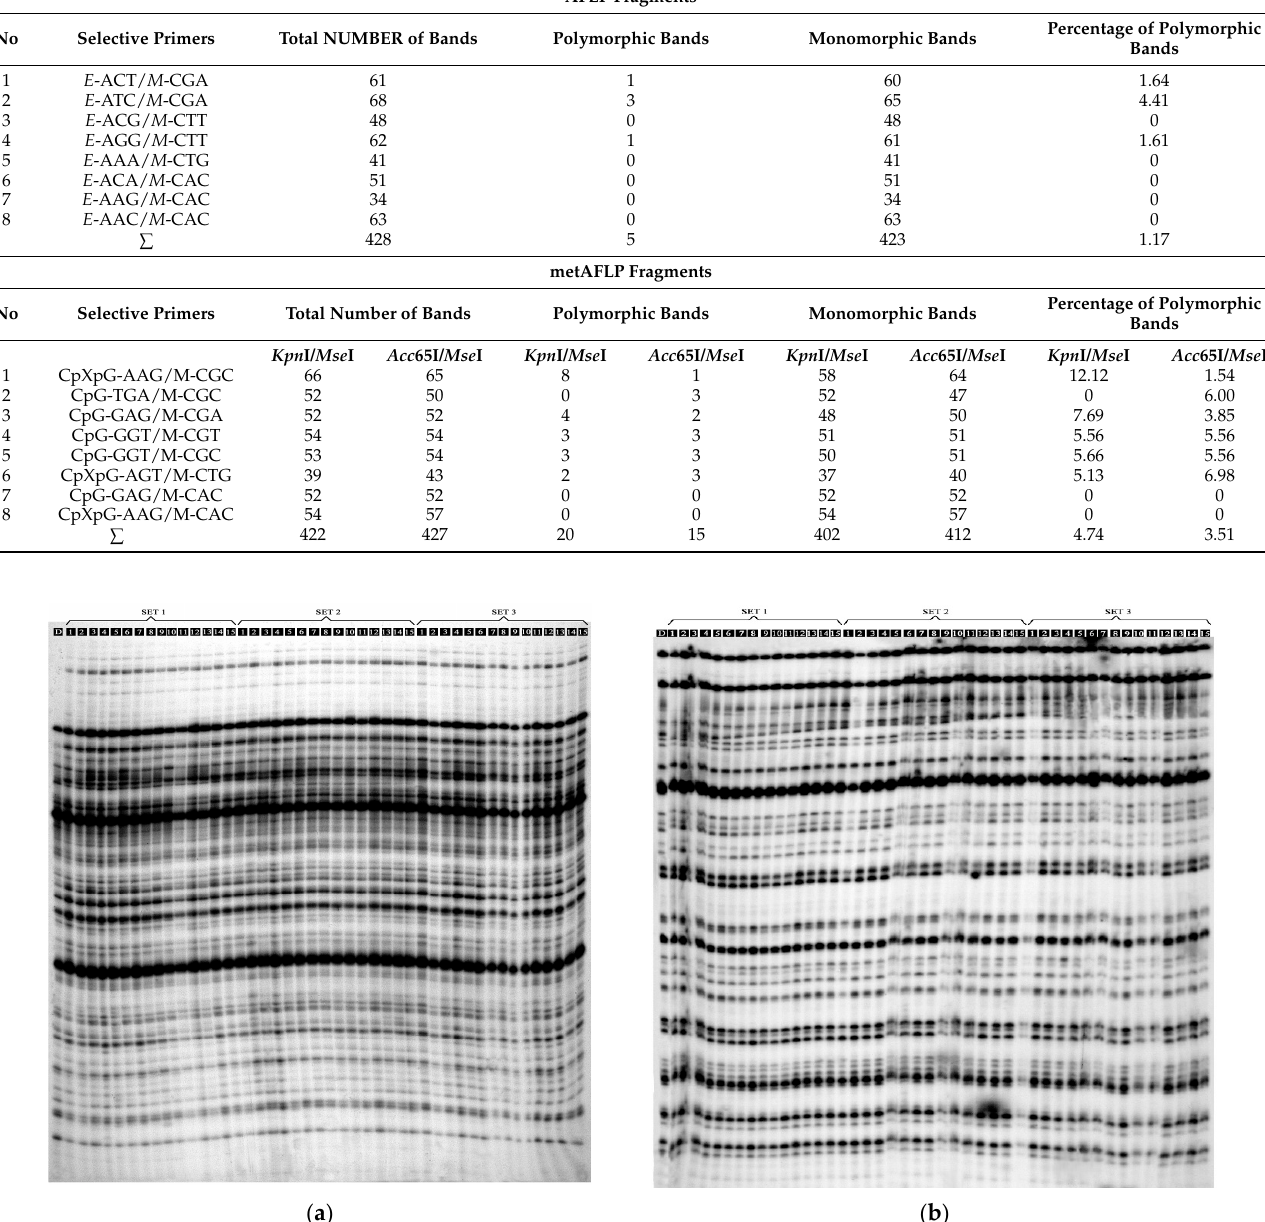
Figure 3. Electrophoretic separation of the: ( a ) amplified AFLP products using E -ACT/ M -CGA, selective primers: (D) donor plant; SET 1: (PSE1-PSE15)—PSE regenerants; SET 2: DSE1-DSE15—DSE regenerants; SET 3: TSE1–TSE15—TSE regenerants; ( b ) amplified metAFLP products using CpXpG-AAG/M-CGC selective primers; genomic DNA was digested with Kpn I/ Mse I: (D) donor plant; SET 1: (PSE1-PSE15)—PSE regenerants; SET 2: DSE1-DSE15—DSE regenerants; SET 3: